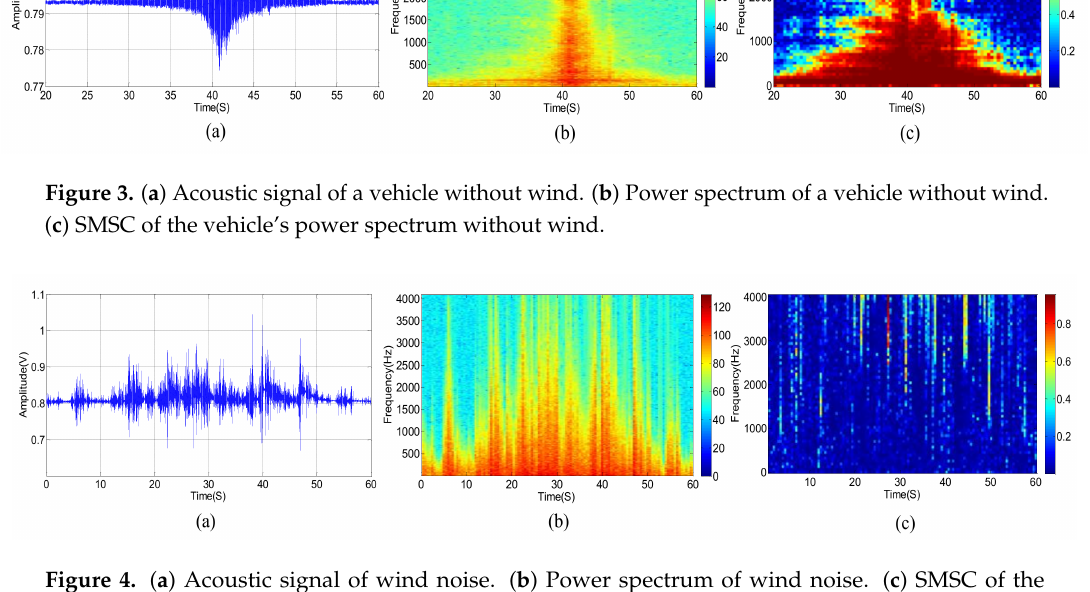
Figure 4. ( a ) Acoustic signal of wind noise. ( b ) Power spectrum of wind noise. ( c ) SMSC of the wind noise.